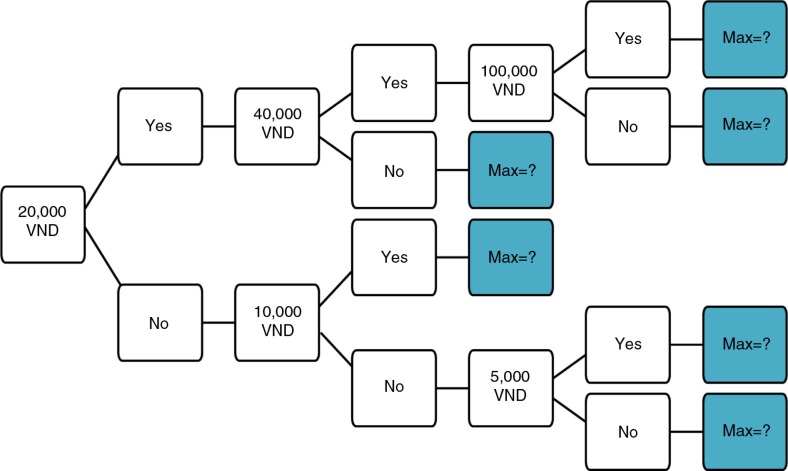
Iterative bidding technique used to elicit willingness to pay for nutrition counseling services in Vietnam.First bidding questions: If a nutrition counseling session costs VND 20,000, are you willing to pay that amount? Exchange rate: US$ 1=VND 20,000.